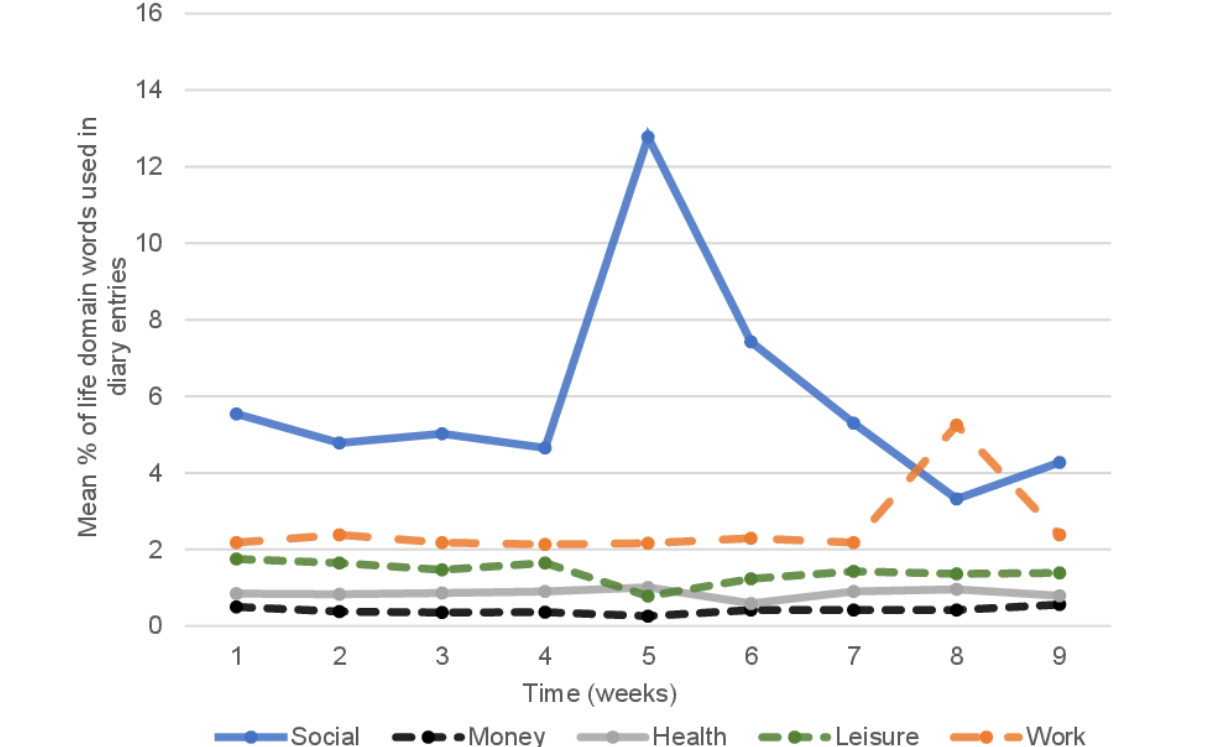
Figure 4. Use of life domain–specific terms in diary entries across